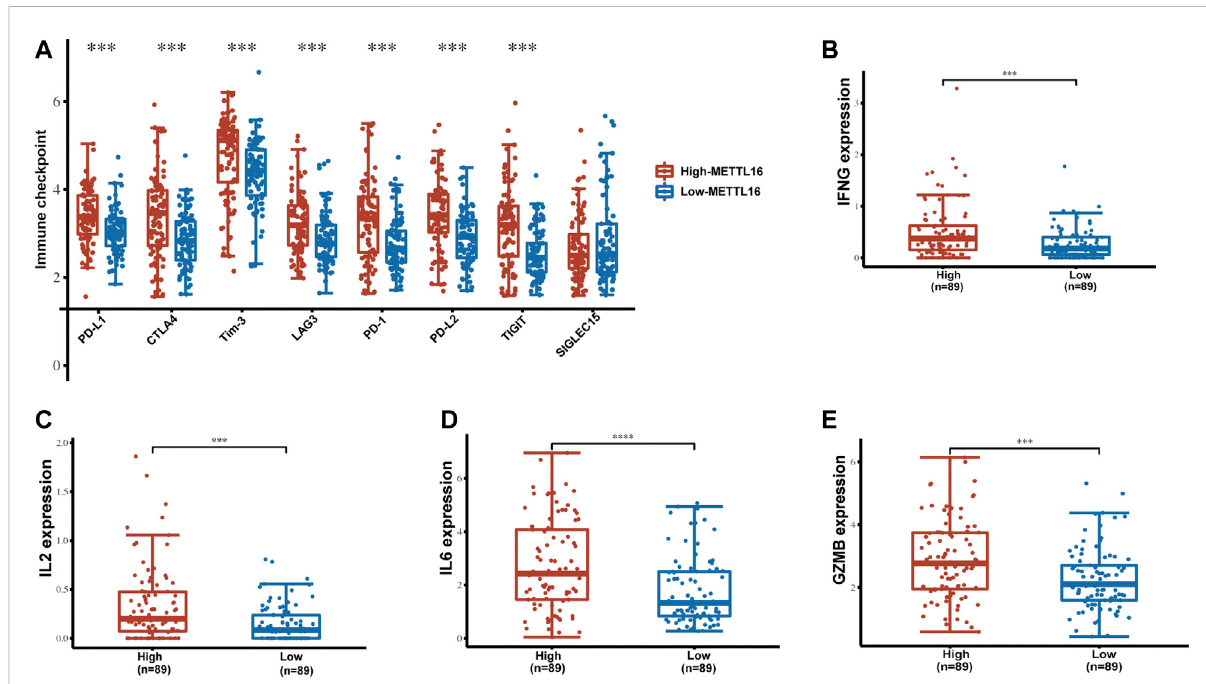
FIGURE 8 Enrichment of immune checkpoints and effector cytokines in the METTL16 high-expression group. (A) Expression distribution of immune- checkpoint – relevant transcripts in METTL16 high- and low-expression groups. (B – E) Analysis of effector cytokines IFN- γ (B) , IL-2 (C) , IL-6 (D) , and GZMB (E) in METTL16 high- and low-expression groups in PDA. The line within the bar marks the median, bars indicate the fi rst and third quartiles, and whiskers above and below the box indicate the 90th and 10th percentiles. *** p < 0.001.